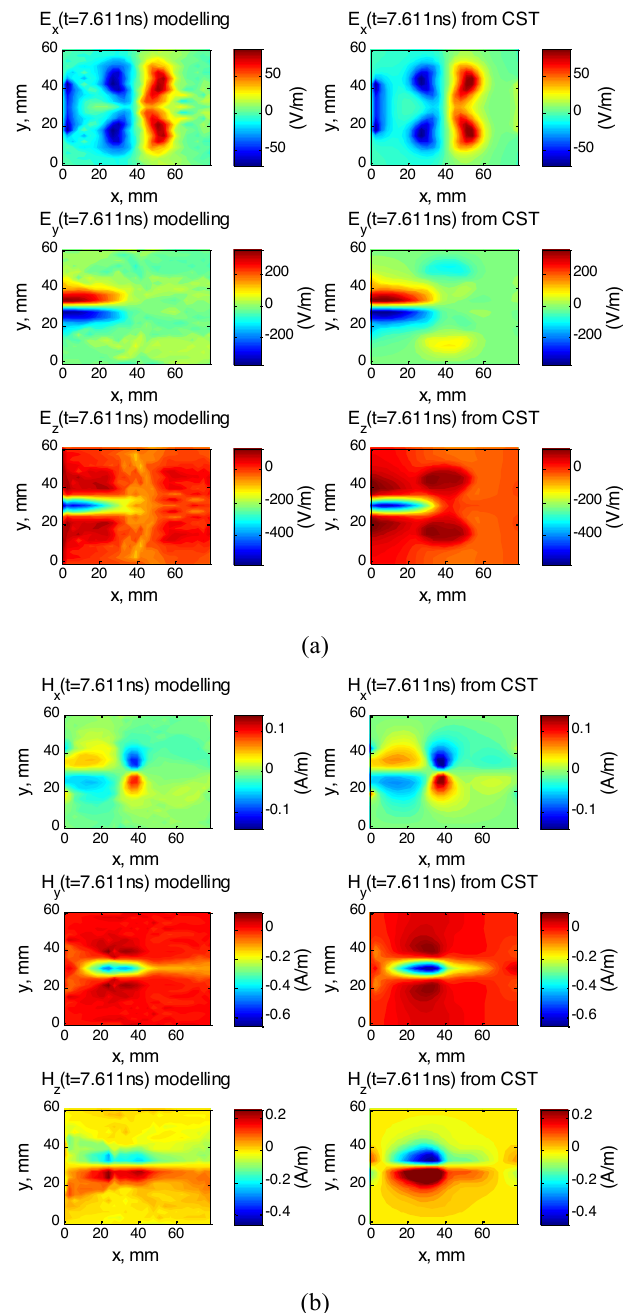
Figure 27: Comparison of the E-field (a) and H-field (b) components obtained from the investigated modeling method and CST MWS in the time-domain.